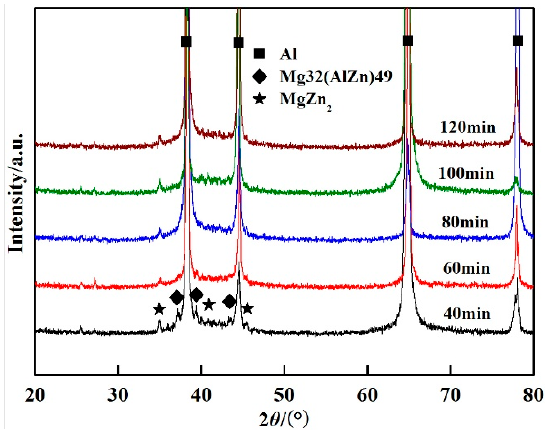
Figure 6. XRD patterns of the welded joints after PWHT with solution at 490 °C for different times followed by aging at 120 °C for 24 h.